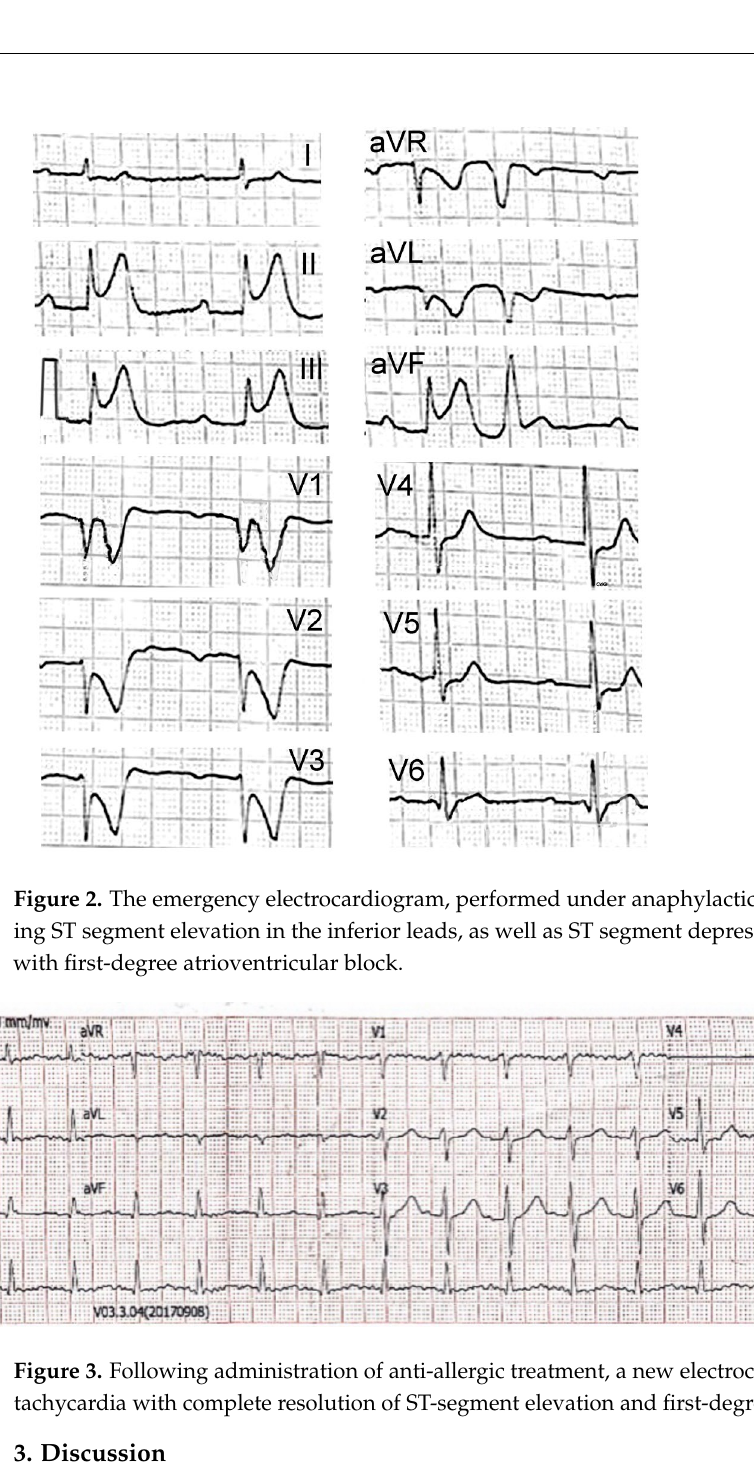
Figure 3. Following administration of anti-allergic treatment, a new electrocardiogram showed si- nus tachycardia with complete resolution of ST-segment elevation and first-degree atrioventricular block.